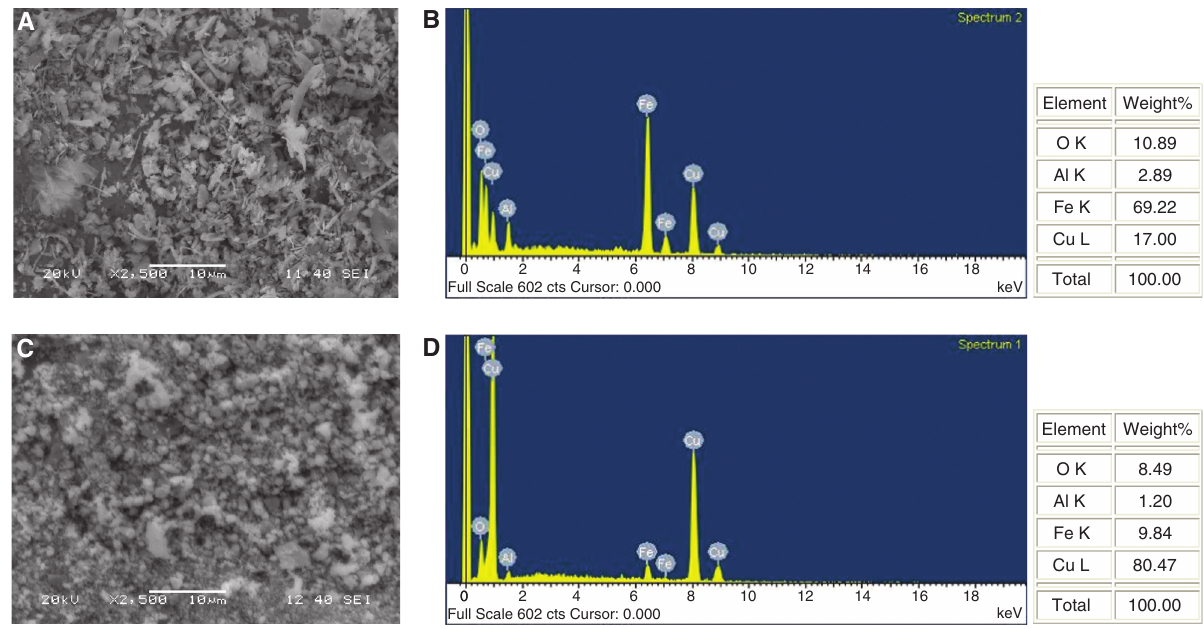
O microcomposite. (B) EDS of the whole micro- 2 3